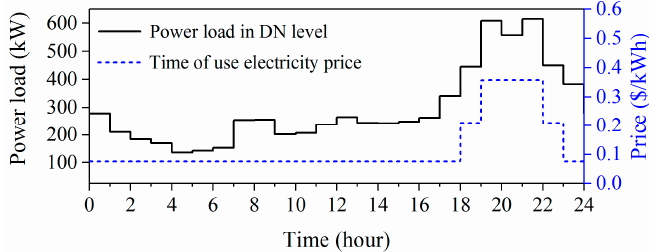
Figure 8. The 24-h power load curve in the distribution network level and time-of-use (TOU) electricity price.